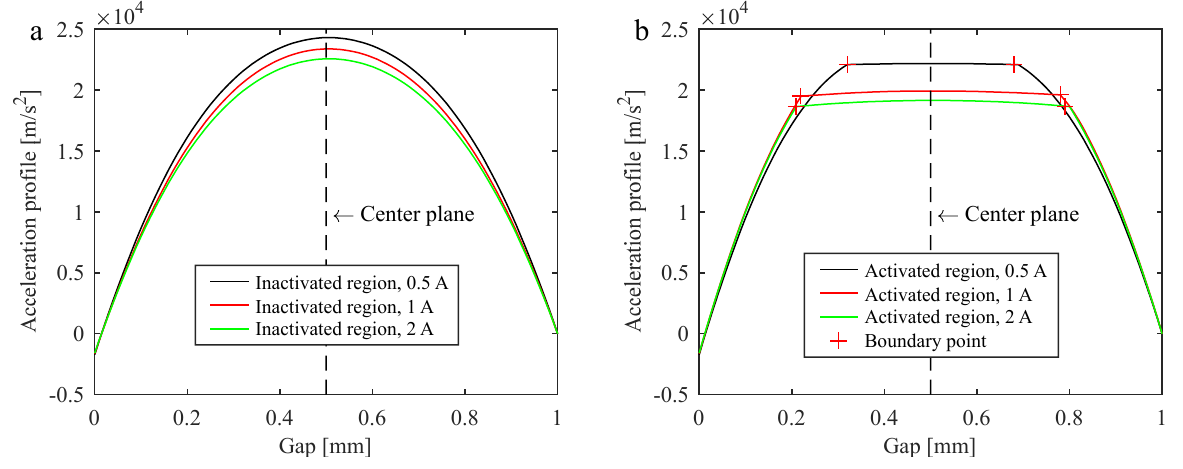
Figure 15. Peak acceleration profiles for different excitation currents.